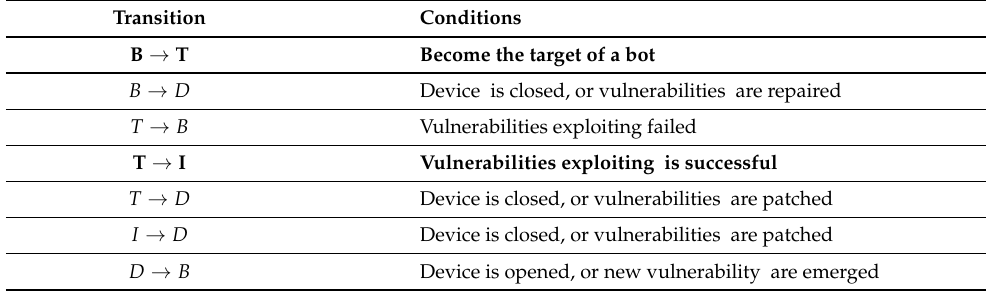
Table 1. The explanation of state transform diagram. Note that the transitions we pay more attention to are in